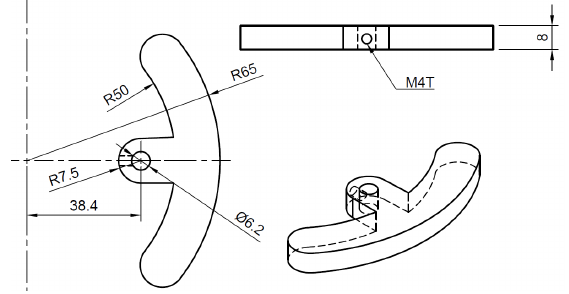
Figure 10. Schematic representation of the bag-pusher. Sizes shown are just for reference and have not been optimized. The design will require adjustments.